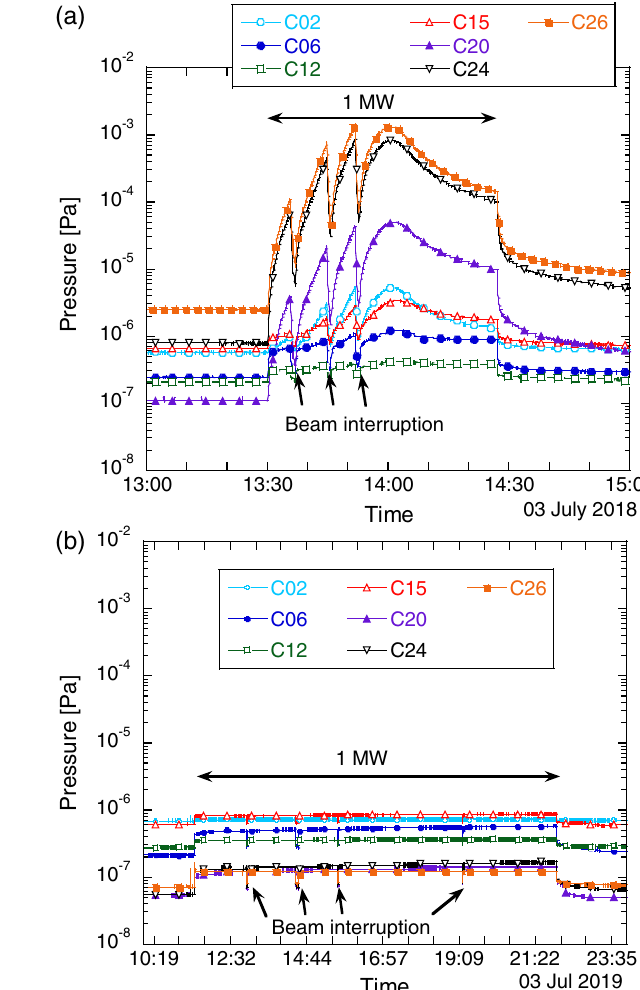
FIG. 17. Beam line pressure in points F and G in Fig. 14. The pressure measured by the same CCGs as Fig. 15 is plotted. (a) [Point F] Pressure during the user operation with the 500 kW beam power. (b) [Point G] Pressure when high-power beam commissioning is performed after the vacuum system shutdown. The beam line has been kept at a vacuum with the TMPs stopped except in the third arc section, where the NEG pumps are additionally installed in the third arc section during the shutdown (Sec. VA). The pressure value of 5 × 10 − 8 Pa is the minimum limit of CCG